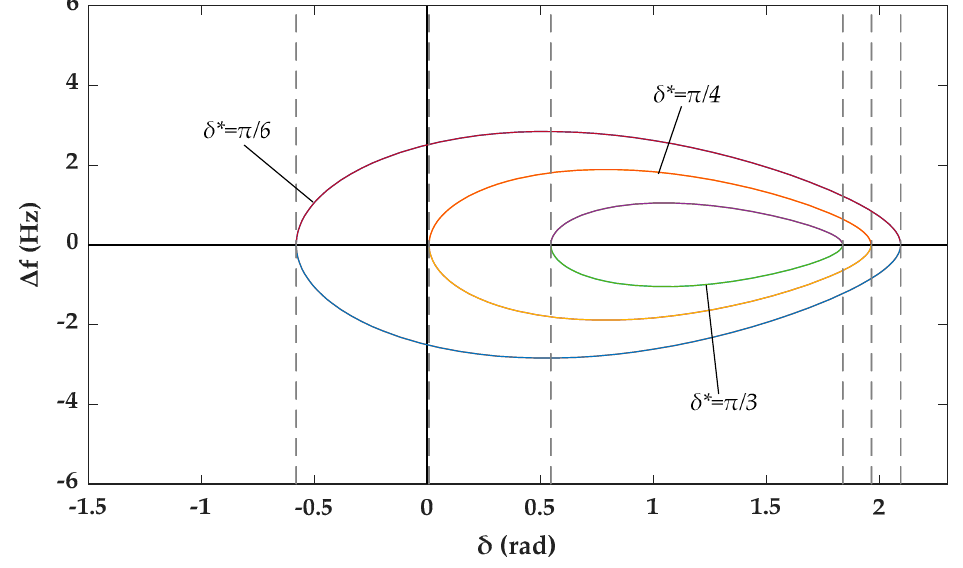
Figure 2. RoA of the single generator infinite bus (SGIB) power system for δ ∗ = π /6, δ ∗ = π /4, and δ ∗ = π